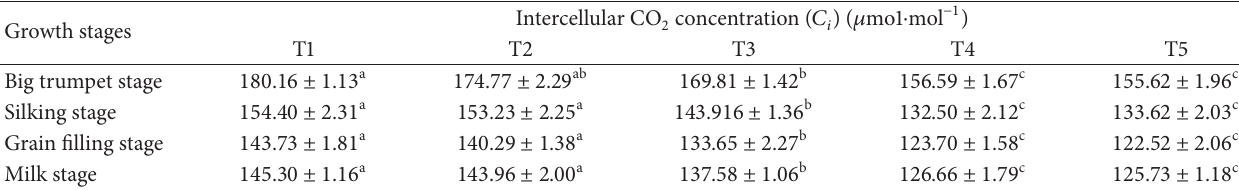
concentration ( 𝐶 𝑖 ) in leaves of 2